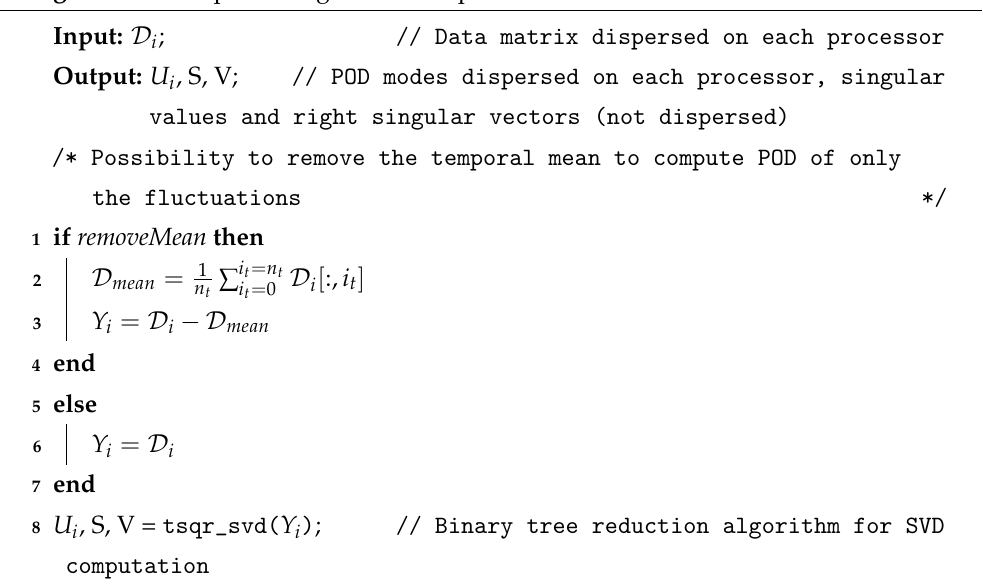
Algorithm 1: Proper orthogonal